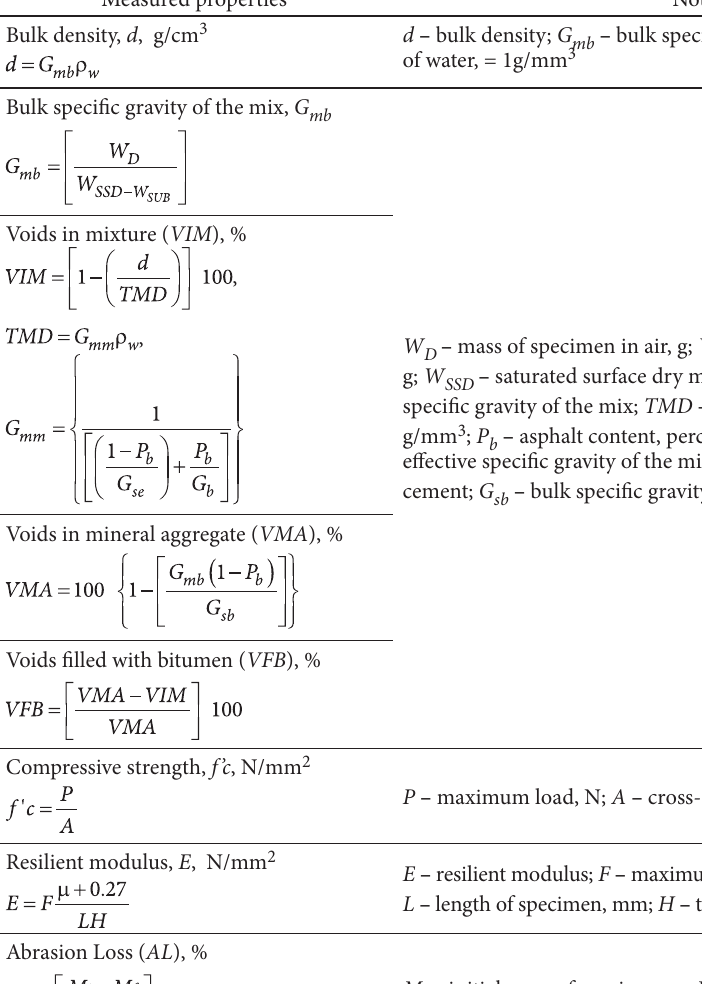
Table 3. List of important formula and the properties of an open-graded asphalt skeleton Measured